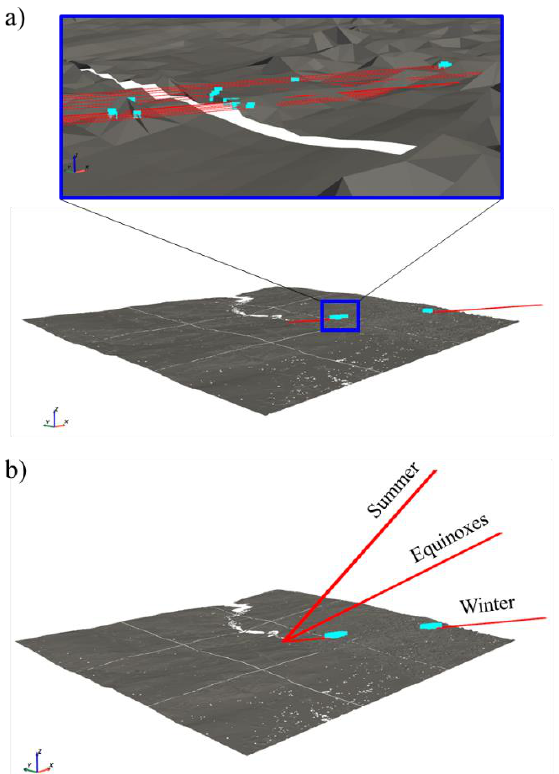
Figure 12. Sun ray intersections with obstacles in the roundabout at 7:30. Sun rays are represented by red lines and intersections are indicated with cyan points: a) winter solstice with zoom in intersections, b) summer solstice, equinoxes and winter